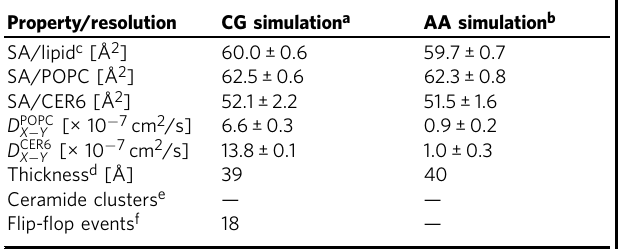
Table 2 Properties of POPC:CER6 (8:2) membrane-only systems simulated in this work (AVERAGE ±